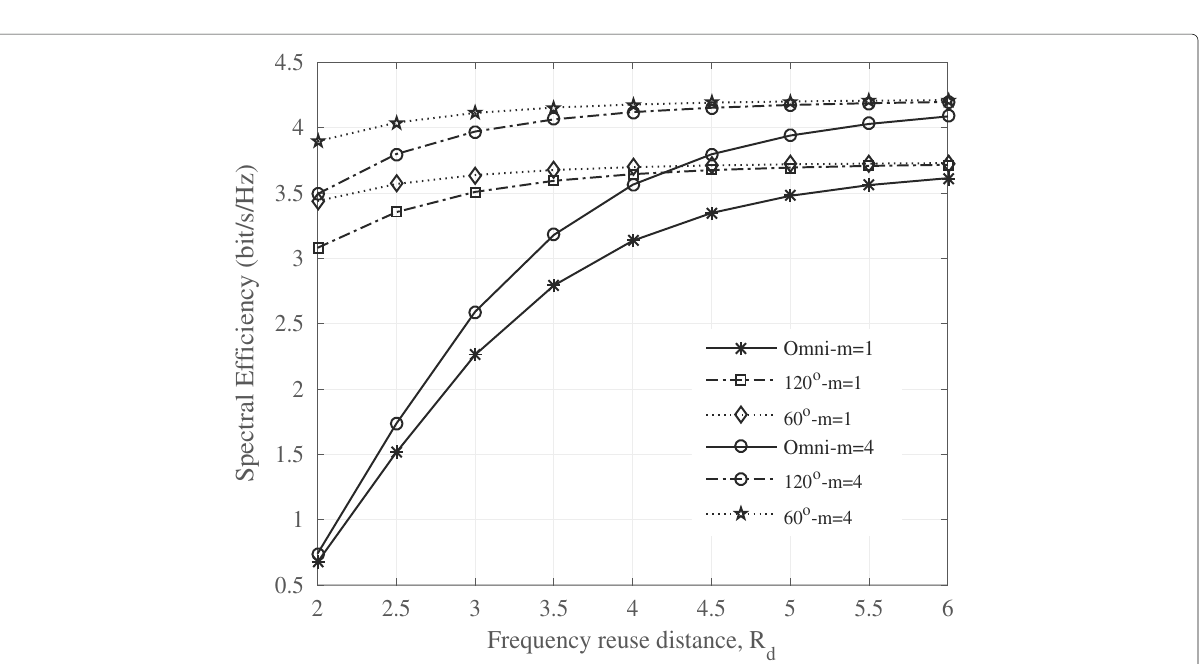
Fig. 6 Spectral efficiency of cellular network for omni, 120 ◦ and 60 ◦ antenna configurations as a function of normalized reuse distance with fading figure, m = 1 and 4, SNR = 10 dB, and α = 4. SE of multi-cell network with omni antenna system for m = 1 and 4 SE of multi-cell network with 120 ◦ sectorized antenna system for m = 1 and 4, SE of multi-cell network with 60 ◦ sectorized antenna system for m = 1 and